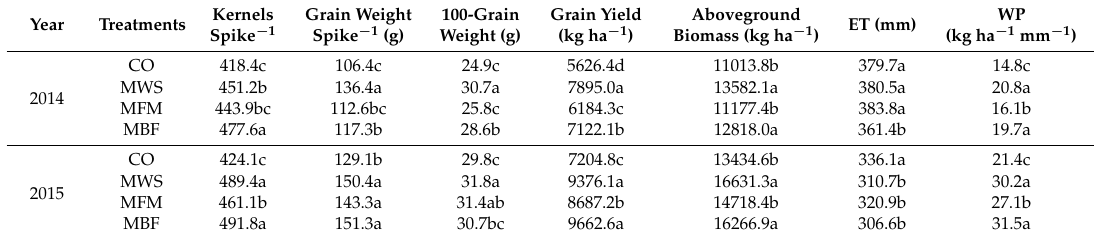
Table 4. Maize grain yield, yield components, aboveground biomass, evapotranspiration (ET), and water productivity (WP) under indicated treatments in the 2014 and 2015 growing seasons.